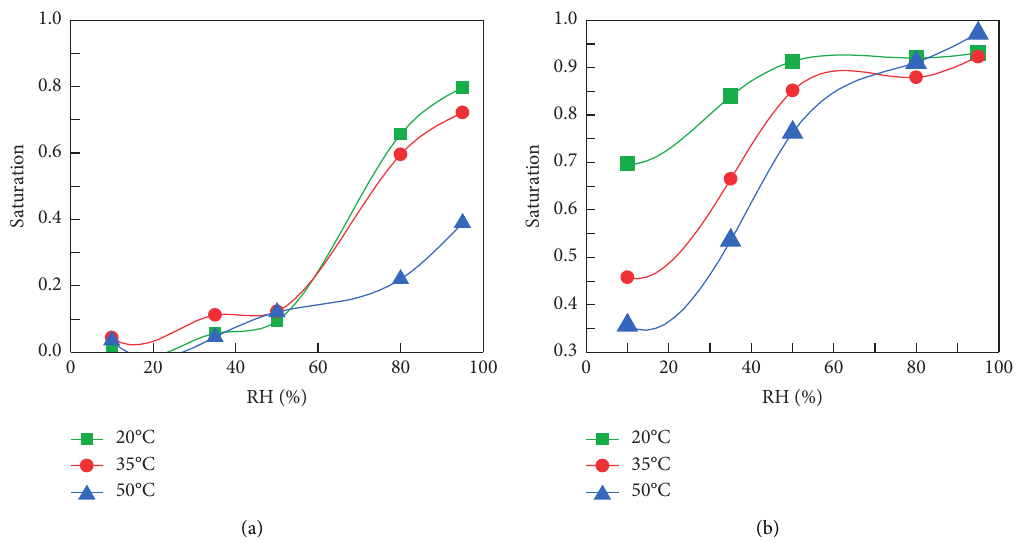
Figure 2: Equilibrium curve of moisture absorption and desorption at 20 ° C, 35 ° C, and 50 ° C: (a) moisture absorption and (b) moisture